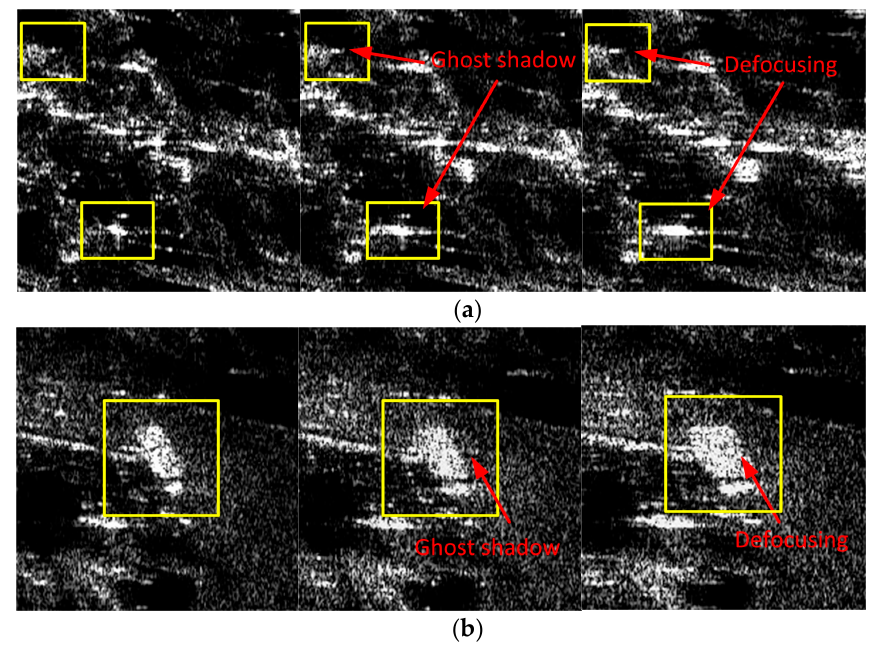
Figure 11. Comparison of four algorithms in Scene 1 and Scene 2: ( a ) Comparison of Scene 1 (left to right: FDFBPA, PTA and Two-step MOCO); ( b ) Comparison of Scene 2 (left to right: FDFBPA, PTA and Two-step MOCO).